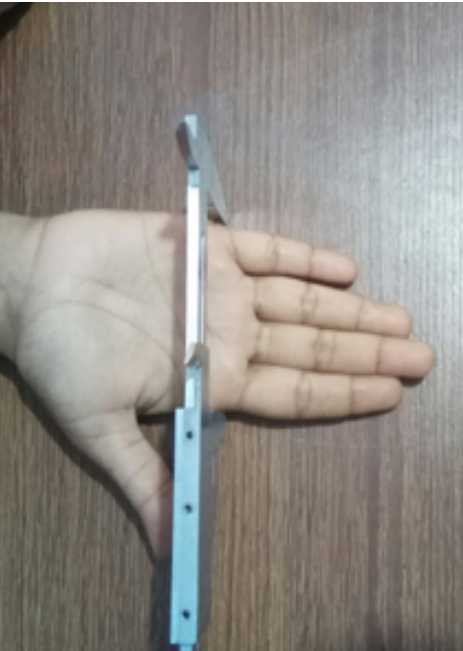
Fig. 3: Measurement of hand breadth